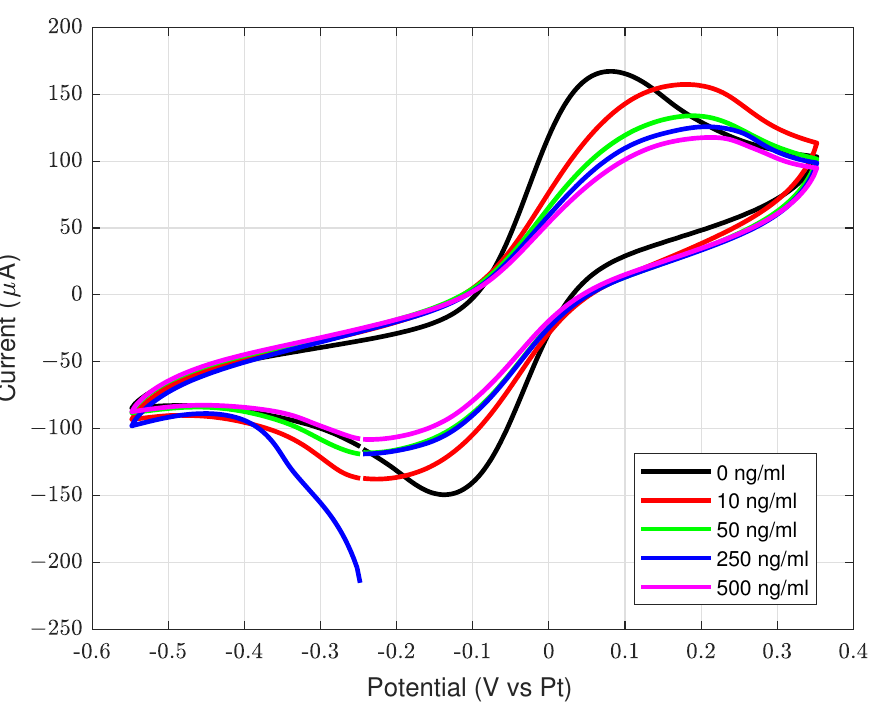
Figure 7. Cyclic voltammograms of MIP modified gold electrode in PBS + redox probe after incubation in analytical solution at different glyphosate